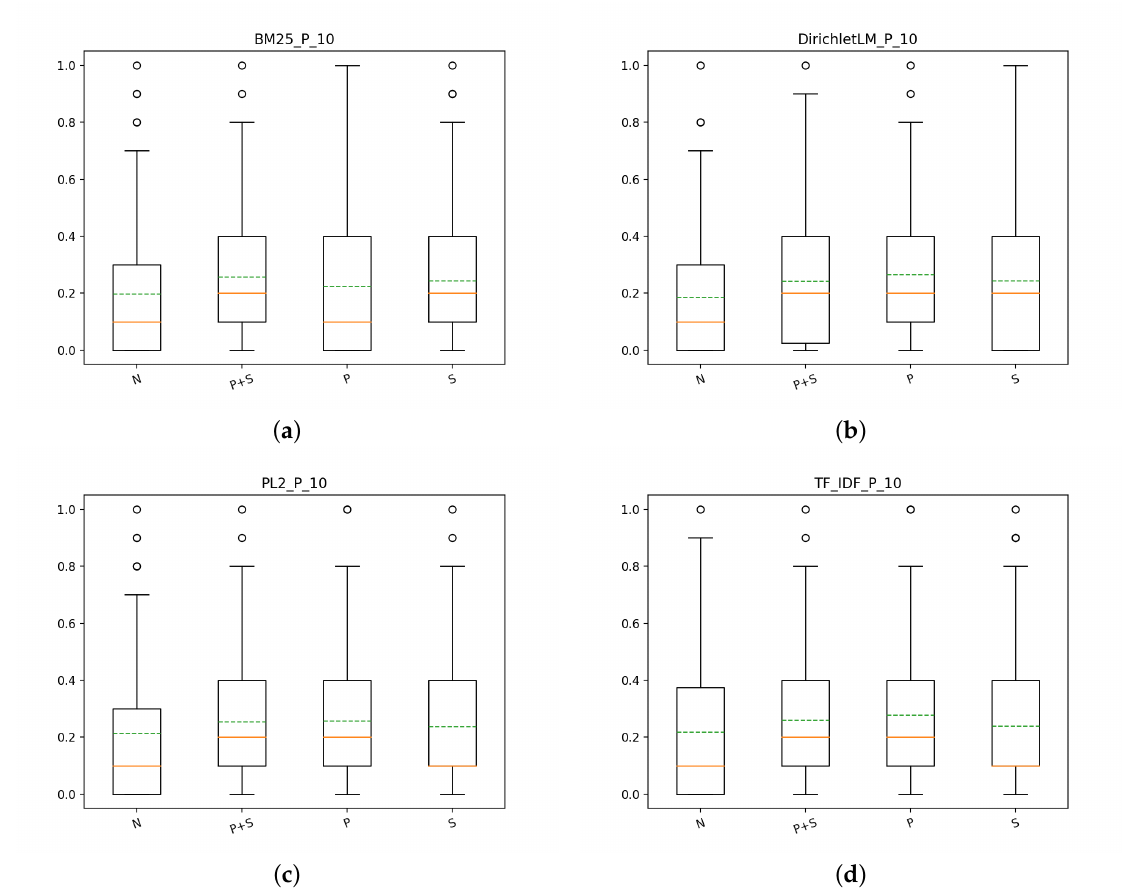
Figure 7. T2: box plots for P@10 of the different indexes for each model: ( a ) Precision for BM25 with different indexes, ( b ) Precision for DirichletLM with different indexes, ( c ) Precision for PL2 with different indexes, ( d ) precision for TF-IDF with different